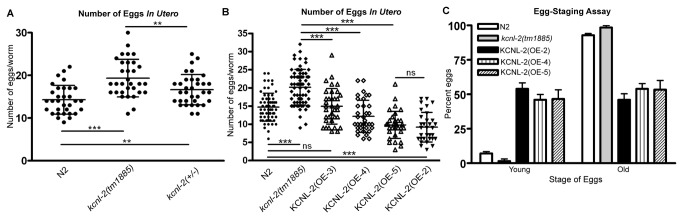
Rescue of the mild Egl phenotype shown by kcnl-2(tm1885) worms.A. kcnl-2(tm1885) animals retain a significantly greater number of eggs in utero relative to N2 animals (P<0.0001). The number of eggs in utero in heterozygotes (kcnl-2(-/+)) is significantly greater than that of the N2 animals (p=0.007), but significantly less than the average number of eggs found in kcnl-2(tm1885) animals (p=0.008). B. Transformation of kcnl-2(tm1885) with 1 ng/µl, 10 ng/µl or 90 ng/µl of p
kcnl-2
kcnl-2(taa2)::gfp gives the transgenic lines KCNL-2(OE-3) (strain VK2220), KCNL-2(OE-4) (strain VK1004) and KCNL-2(OE-5) (strain VK1041), respectively. The average number of eggs retained in utero by KCNL-2(OE-3) was not significantly different from the N2 animals (P=0.8) but was significantly different from the kcnl-2(tm1885) organisms (p<0.0001). KCNL-2(OE-4) and KCNL-2(OE-5) retain fewer eggs in utero than N2 animals (p<0.005; p<0.0001, respectively) and kcnl-2(tm1885) animals (p<0.0001) (Student’s t test). C. Egg-staging assays show that the proportions of young eggs from KCNL-2(OE-2) (54.0±4.3%), KCNL-2(OE-4) (46.0±3.9%), and KCNL-2(OE-5) (46.6±6.7%) are significantly greater than those of N2 (7.2±1.3%) & kcnl-2(tm1885) worms (1.6±1.6%) (p<0.05; n=3, Kruskal–Wallis H test).